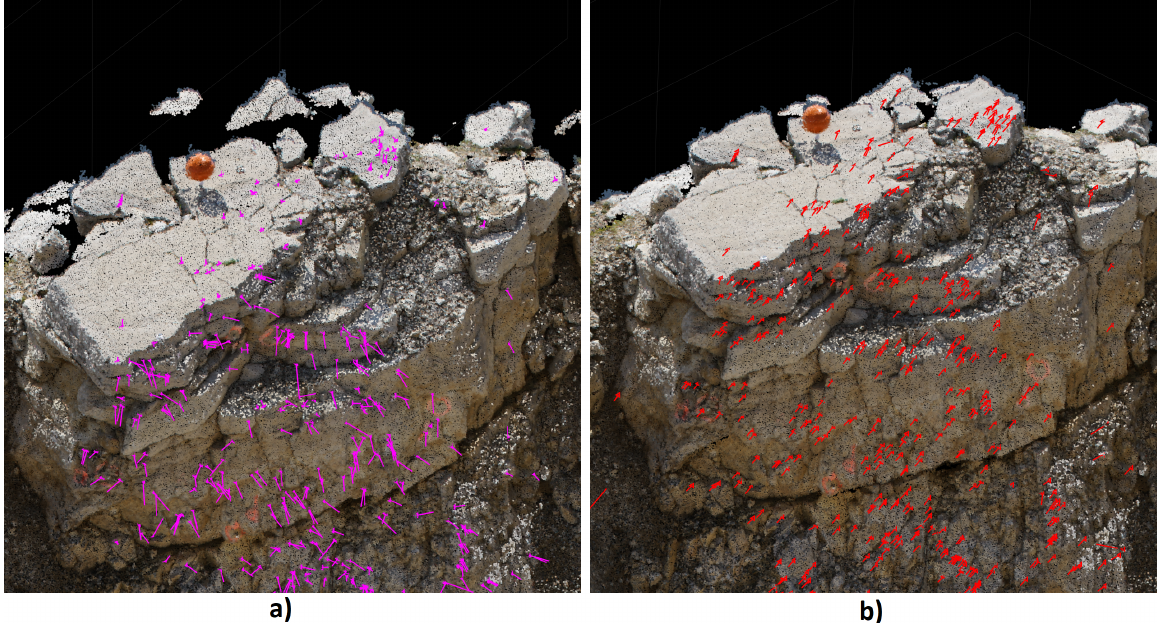
Figure 6. Detailed view of the results of the change analysis using different strategies, a) Motion vectors calculated from the M3C2 distances and their local normals, b) Motion vector obtained by the proposed